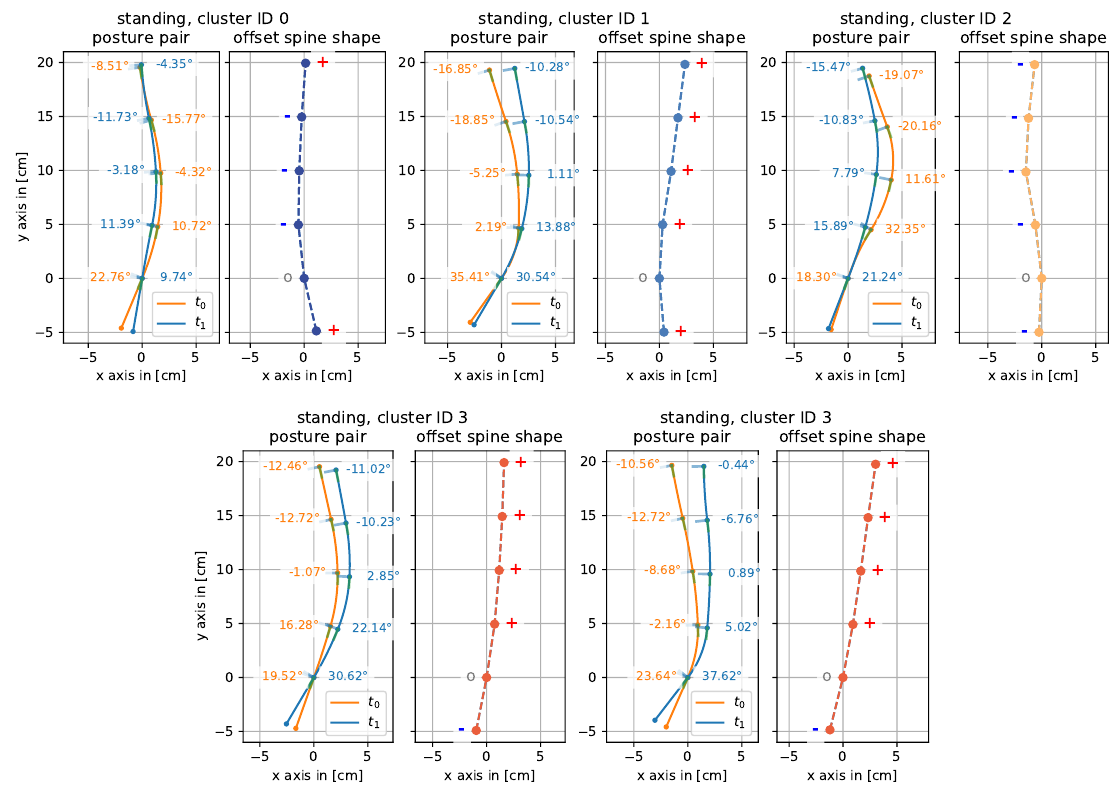
Figure A2. Results for clustering posture pairs of sitting : Cluster representative sample posture pairs and offset spine shapes for each cluster. Each sample’s position within its cluster is marked by an ‘x’ in the colored t-SNE map.